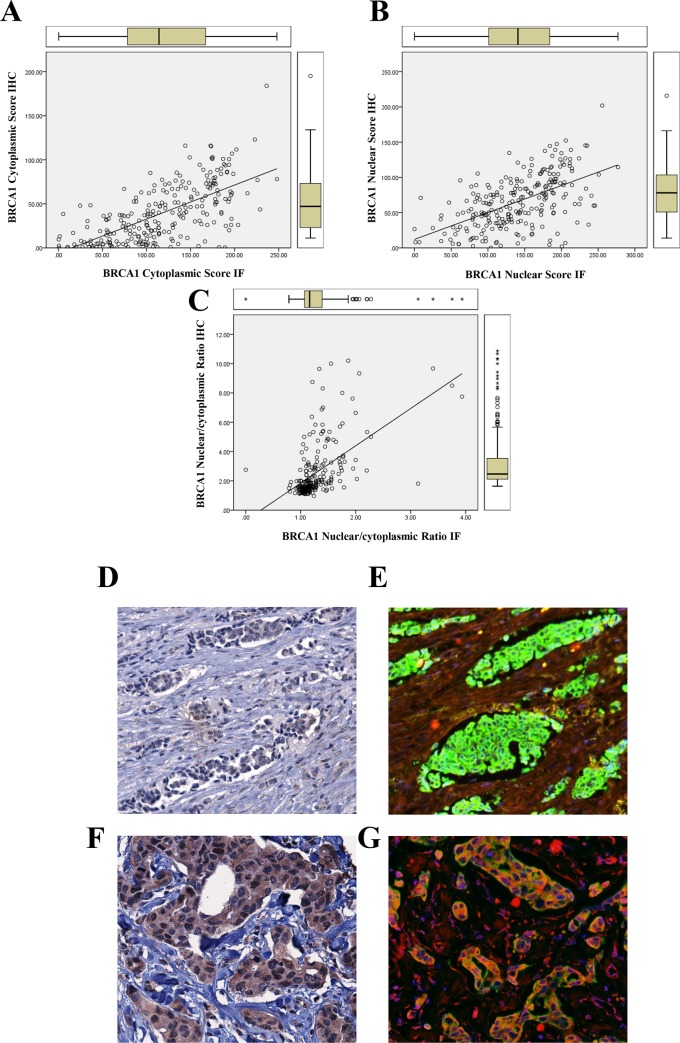
Dual IF vs IHC staining for BRCA1 analysis.Plot of pairwise dual IF versus IHC digital H-score for BRCA1 showing a good correlation between the two staining methods for cytoplasmic scores (A), nuclear scores (B), and nuclear/cytoplasmic ratios (C). Figures D to G demonstrate the correlation between the IHC staining (Figs. D and F) and the dual IF staining (Figs. E and G) in the corresponding cores.